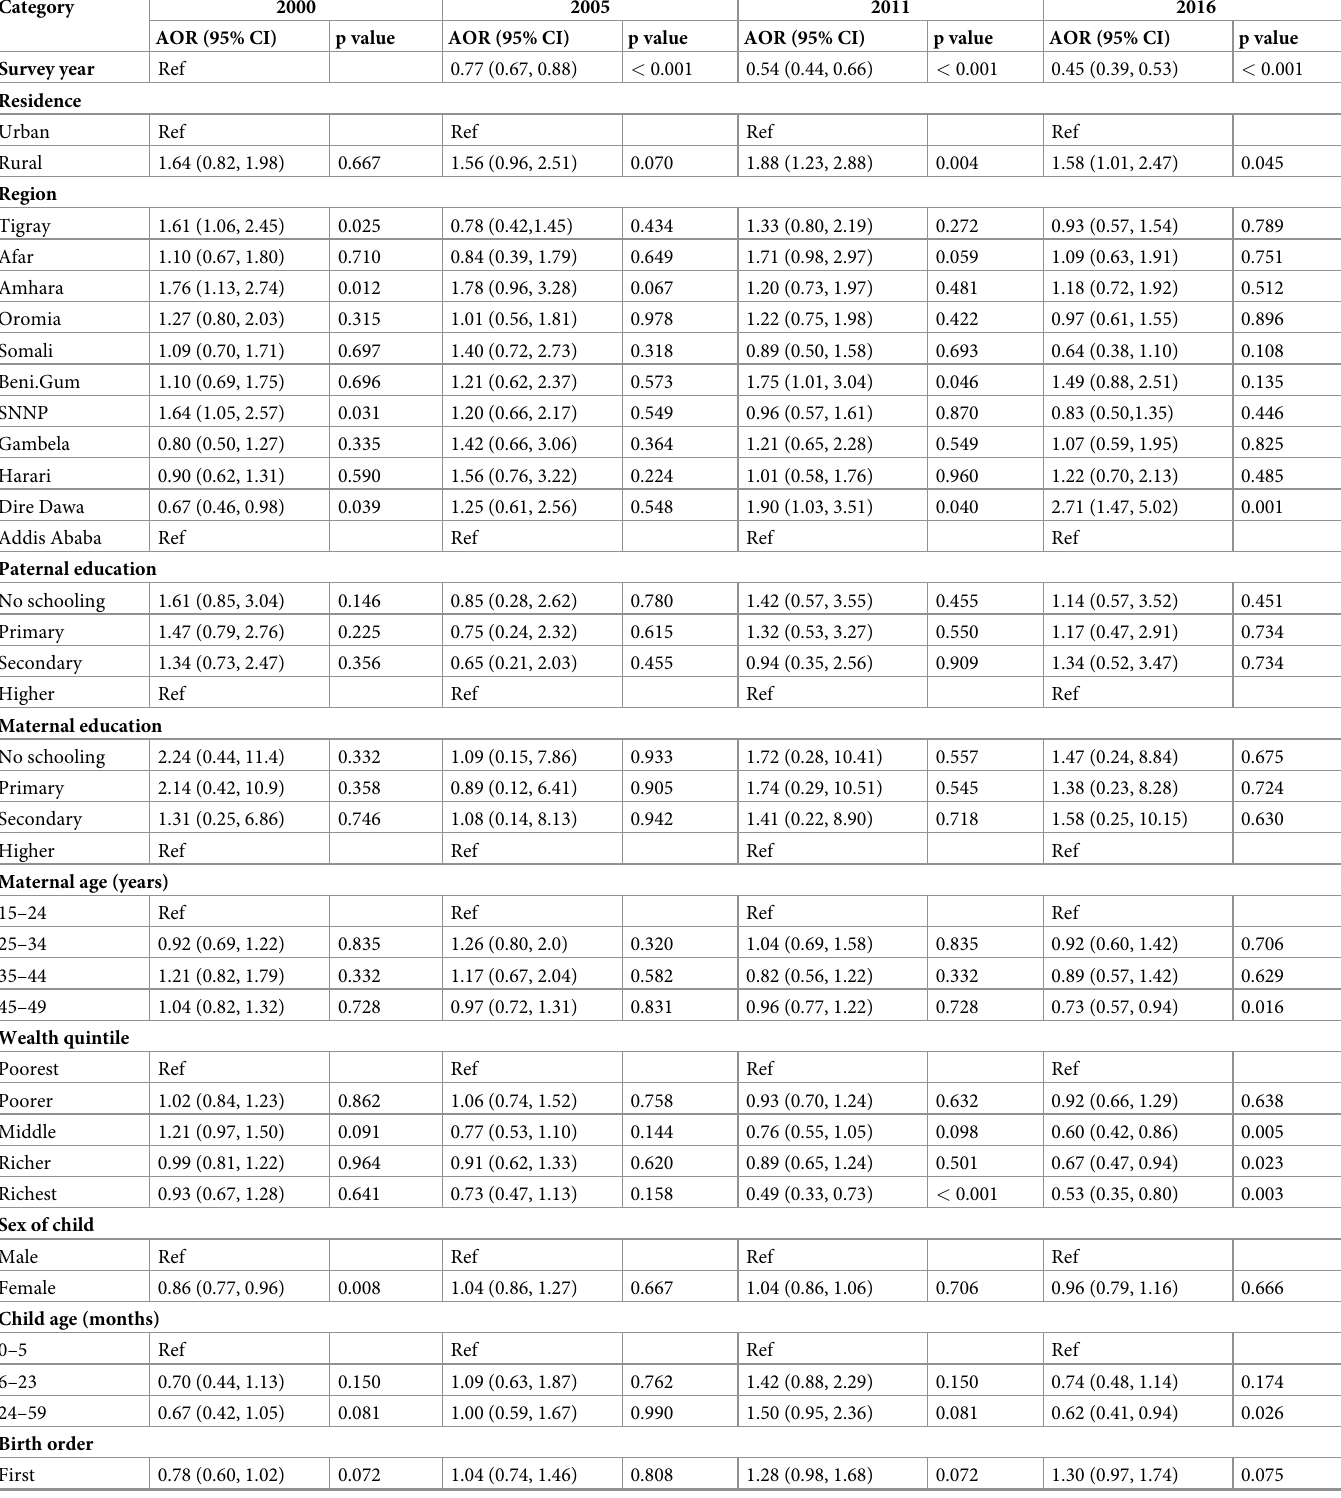
Table 2. Trends in adjusted odds ratios for stunting, EDHS 2000 to 2016.